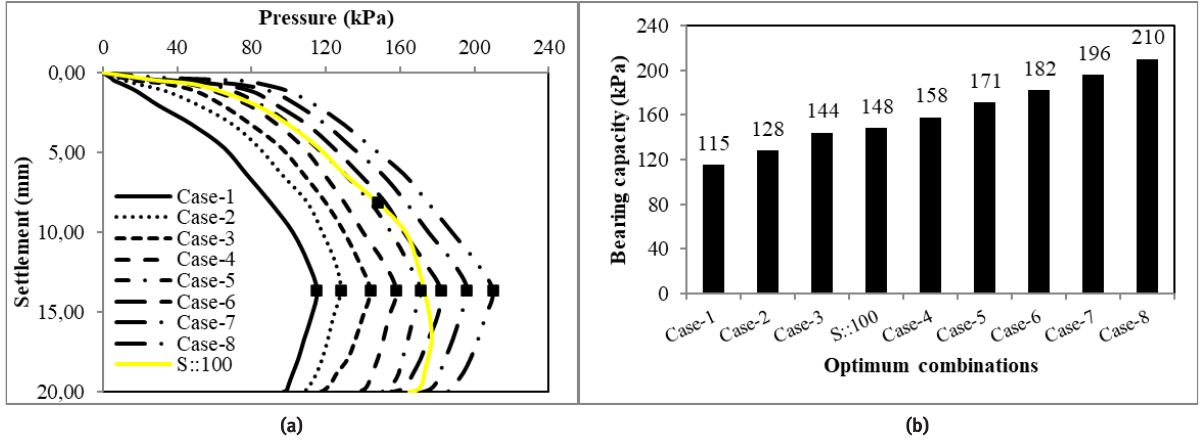
Figure 7: (a) Pressure–settlement curves and (b) bearing capacity values of two-layered soil for all cases at h/B=1.225 and single-layer sandy soil for L/B=1.